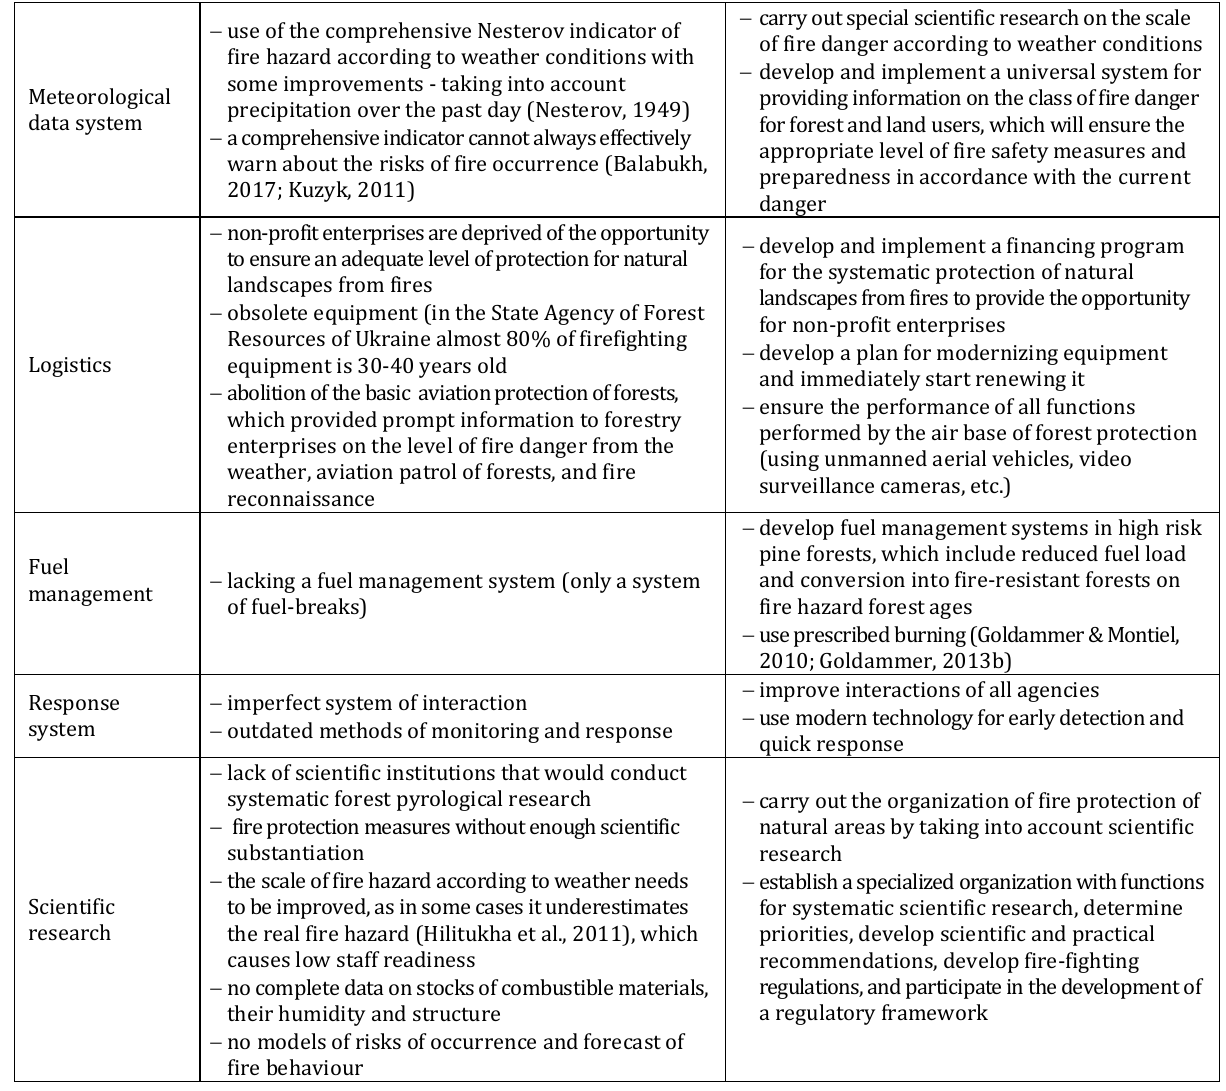
Table 2. Views and visions of practitioners for improving the Landscape Fire Management System (Source: Evaluation of a questionnaire based on returns by154 respondents from 21 oblasts of Ukraine (2020)